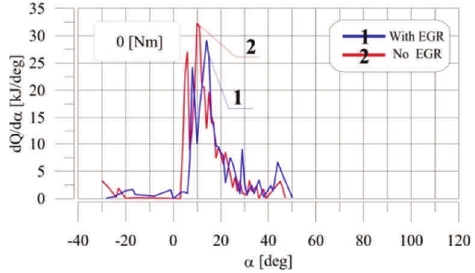
Fig. 13. Influence of the engine crank angle on the rate of heat release inside cylinder for engine operating with/without EGR at torque 0 Nm